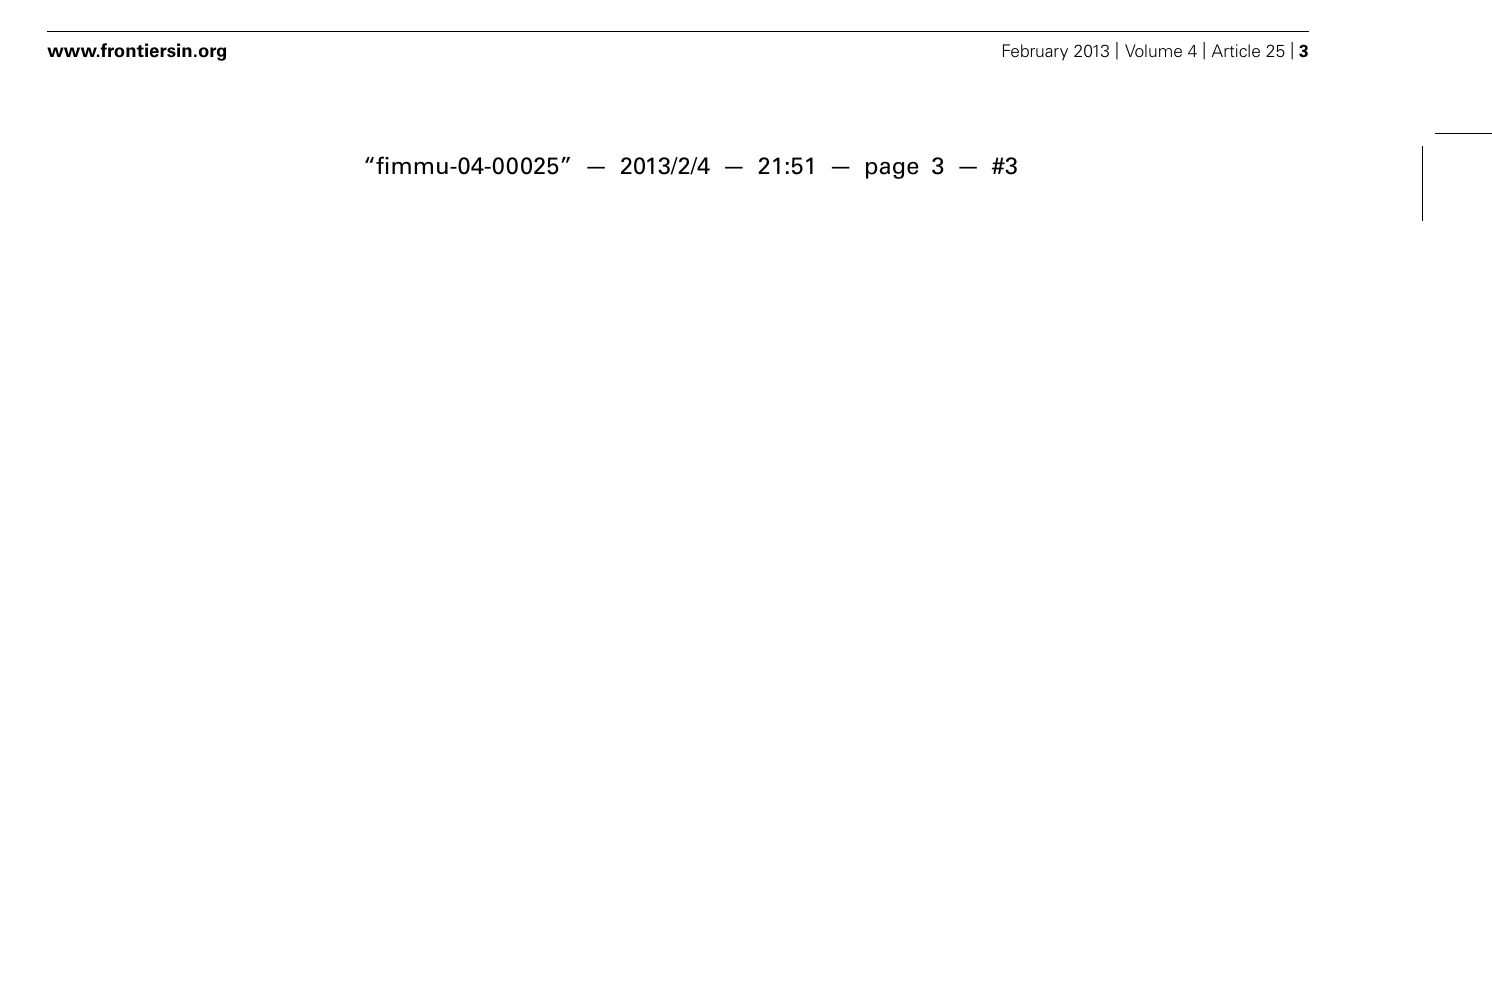
to promote immune regulation. Oral intake of mutant strains lacking LTA expression (LTA − L. acidophilus ) predominantly results in suppression of exacerbated immune responses via the induction of regulatory IL-10-secreting DCs (B) , which then promote the conversion of naiveT cells into iTregs. (B) Confocal microscopy analysis of DCs (CD11c + , green; CD11b + , red) that produce IL-10 (white) in the colons of healthy control mice after treatment with LTA-deficient L. acidophilus